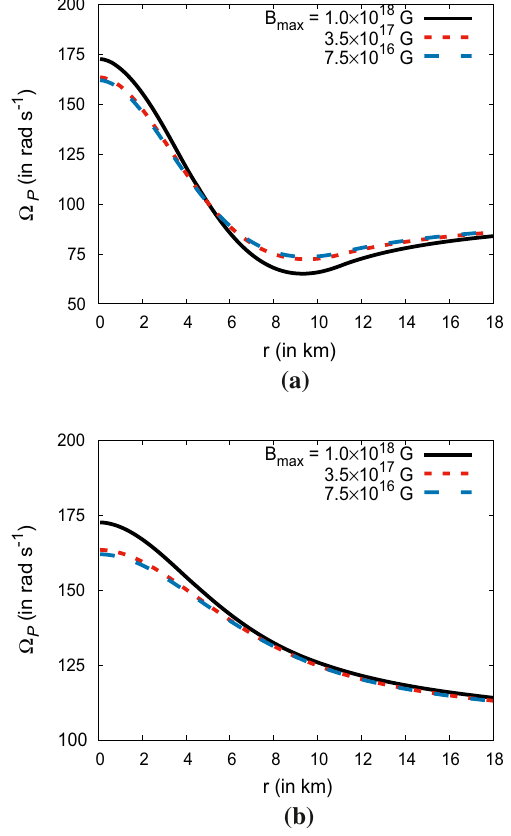
Fig. 19 We have plotted the effect of a poloidal magnetic field on Ω P alongtheequatorialplane( a )andpolarplane( b ).Theblacksolidcurve, the red short dashed curve and the blue dashed curve are for central magnetic field of 1 . 0 × 10 18 G , 3 . 5 × 10 17 G , 7 . 5 × 10 16 G respectively. Ω is taken to be 100 rad s − 1 . The central energy density of the NS is taken to be 1 . 0 × 10 15 g cm −